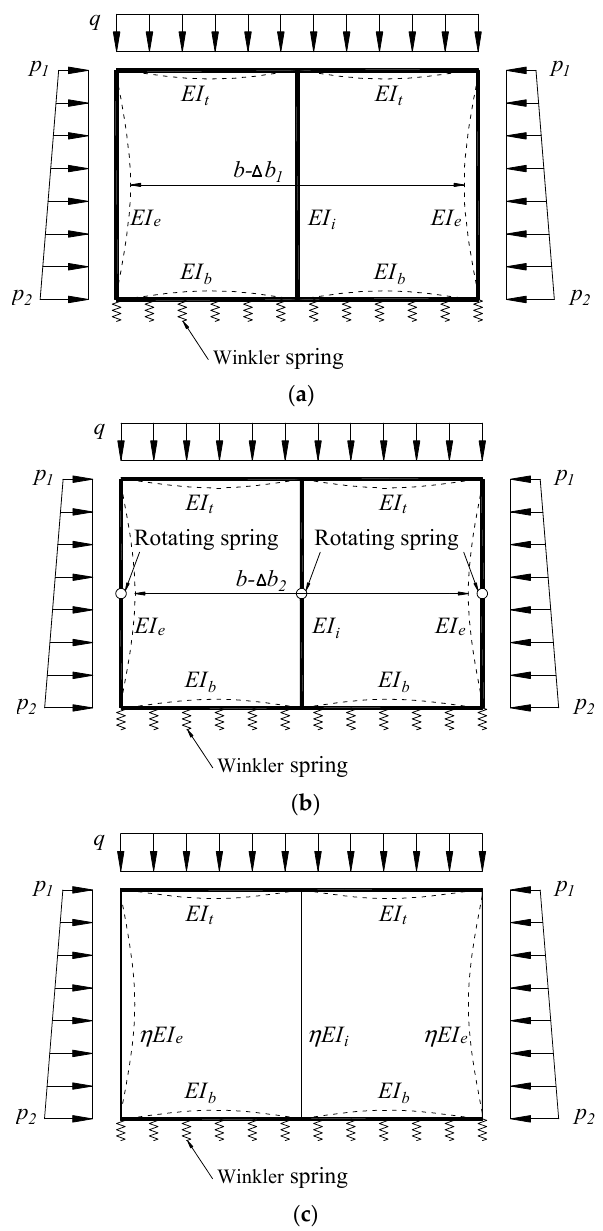
Figure 2. Structural systems for PUTCGEs: ( a ) uniform stiffness model, ( b ) beam-spring model, and ( c ) stiffness reduction model.